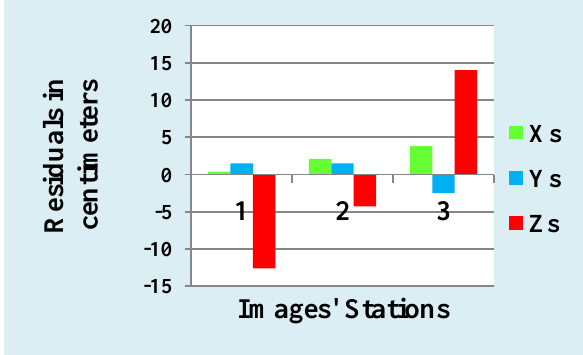
Figure 4. Shows the position residuals of images taken in the Southwest flight direction